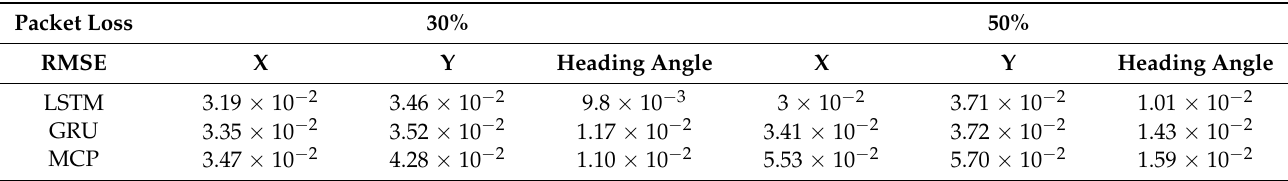
Figure 7. Prediction errors: ( a ) error for X; ( b ) error for Y; ( c ) error for heading angle. Table 1. RMSE of prediction